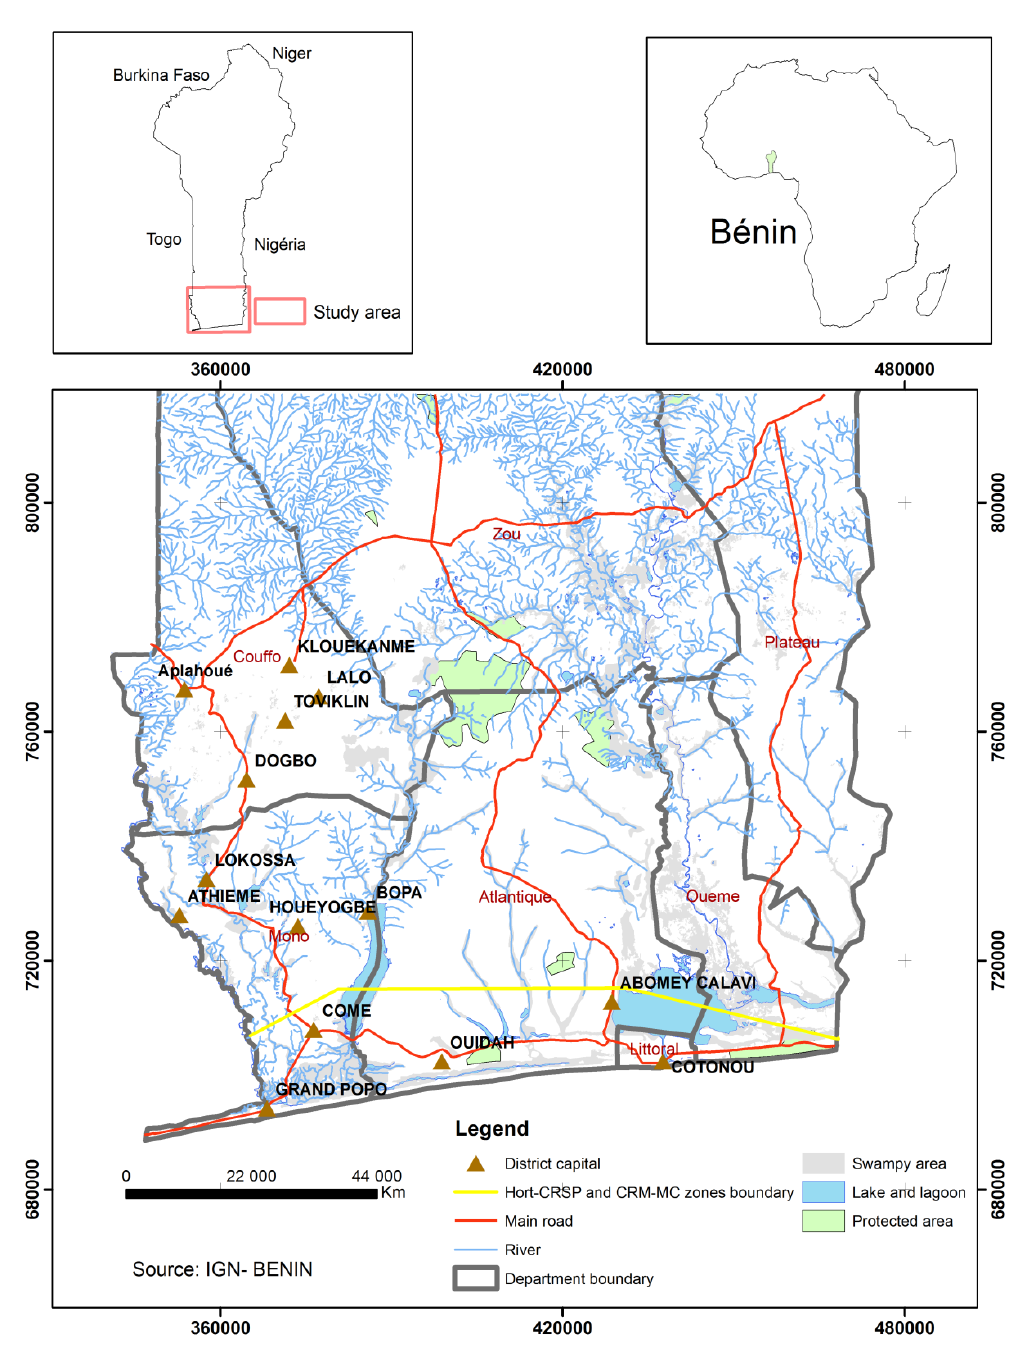
Figure 1. Location of the two survey sites in southern Benin (Cotonou and Abomey Calavi). The EFNs are cut to cover an iron or wooden frame over a small plot. They are generally made of recyclable polyethylene or, more recently, from starch. The mesh size recommended depends on climate and the size of the pests to be excluded. In tropical Benin both fine mesh nets (0.4 mm) and larger mesh (0.9 mm) are used to protect cabbage from major lepidopteran pests ( Plutella xylostella , Hellula undalis , Helicoverpa armigera and Spodoptera littoralis ) and aphids ( Lipaphis erysimi ). EFNs are usually removed during daylight hours, when pests specializing in cabbage are inactive, to enable regulation